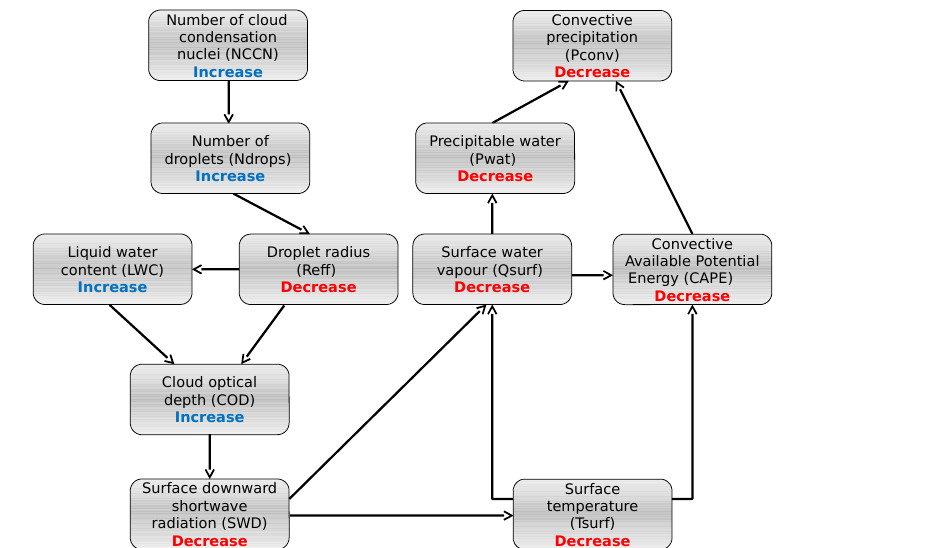
Figure 8. Schematic summary of the proposed aerosol causal chain sequence for the indirect effect of aerosols on convective